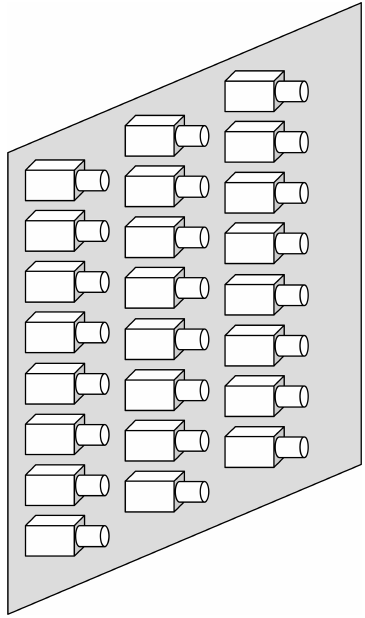
Figure 6. Array of spectrograph–telescope combinations of identi- cal